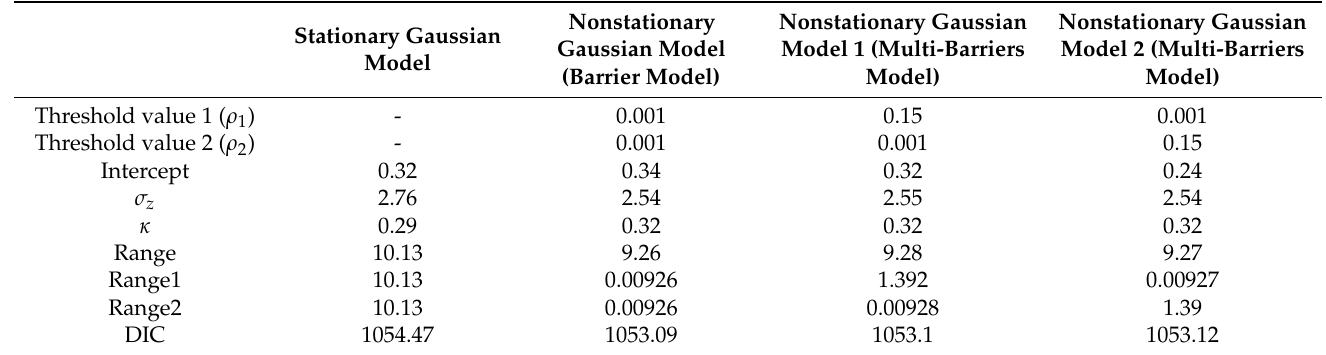
Table 1. Posterior mean, threshold and deviance information criteria (DIC) value for the parameters of each